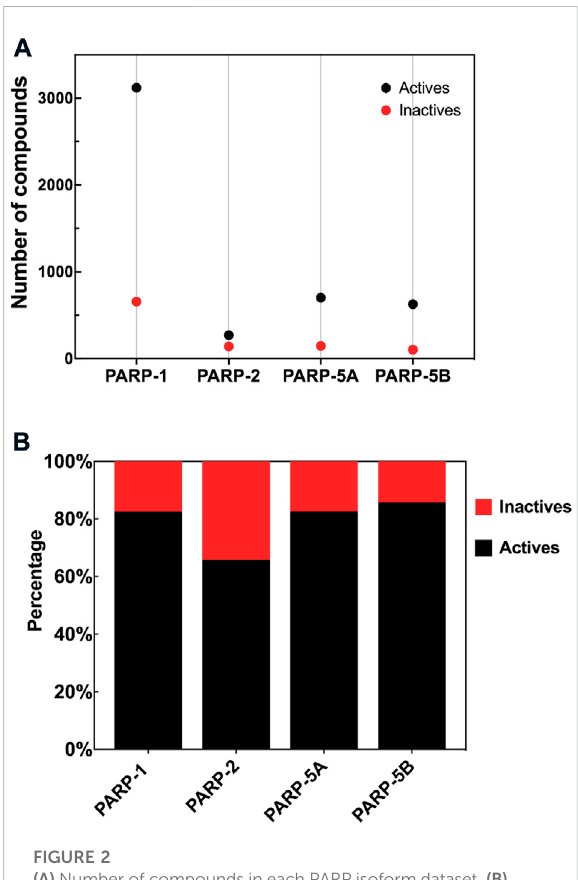
FIGURE 2 (A) Number of compounds in each PARP isoform dataset. (B) Percentage of active and inactive compounds in each PARP